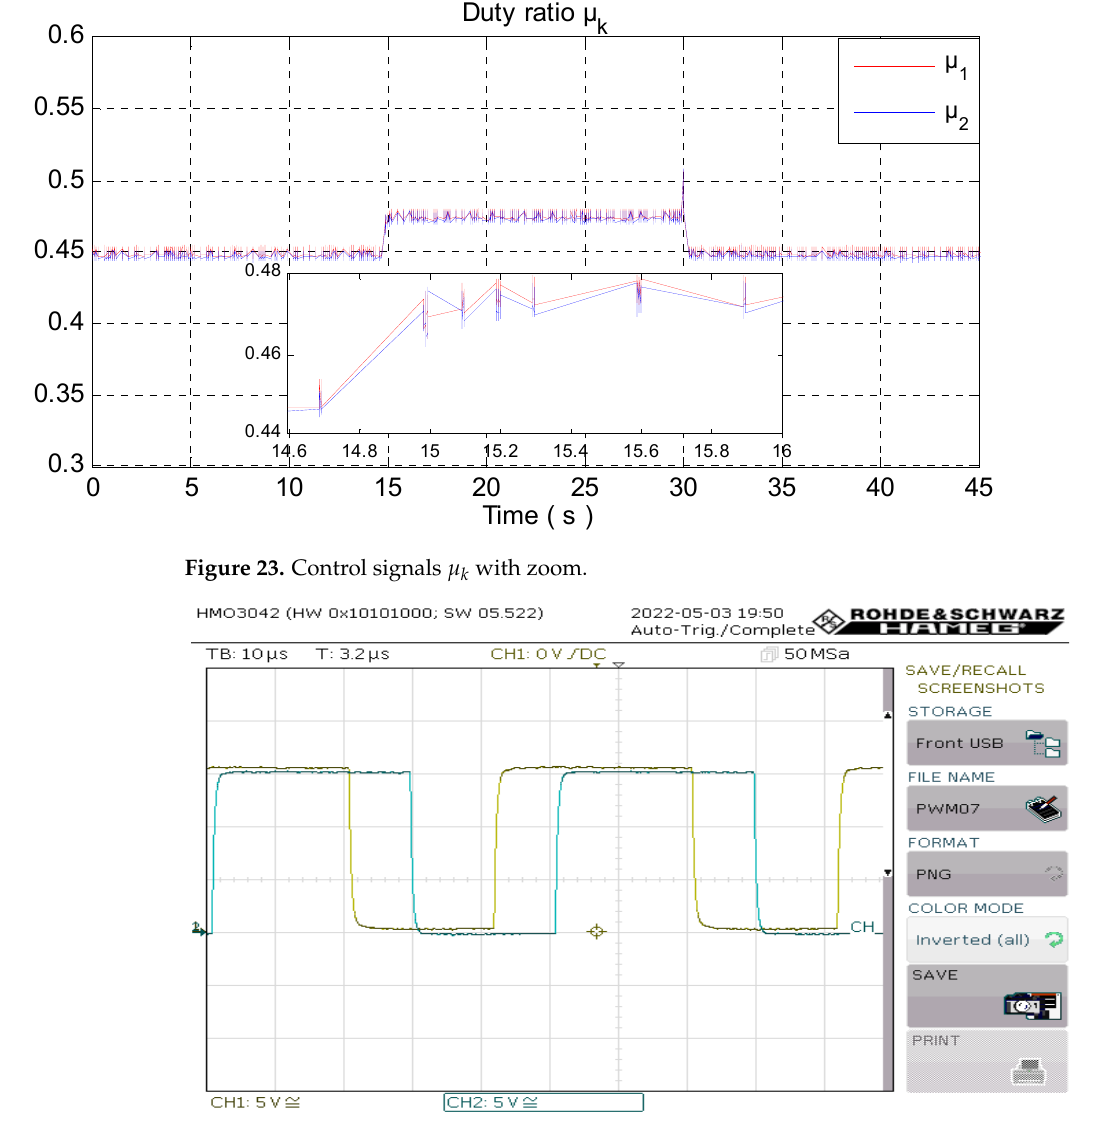
Figure 24. Pulse width modulation of IBBC.